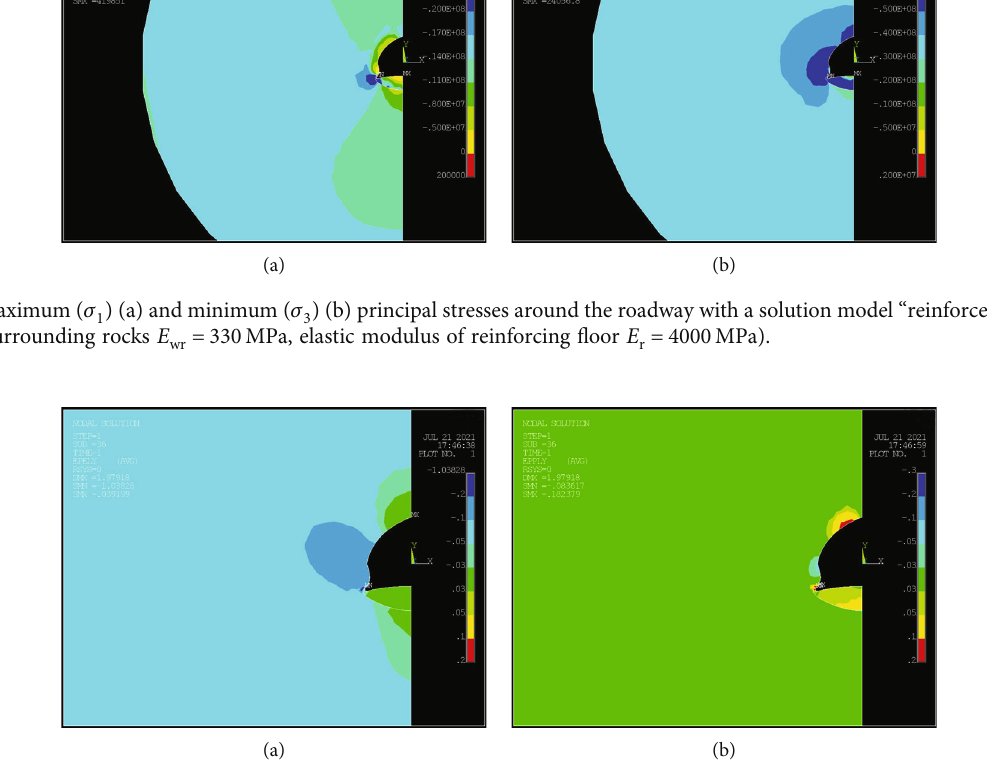
Figure 12: Vertical elastic (a) and plastic (b) strains around the roadway with a solution model “ reinforced fl oor ” (elastic modulus of surrounding rocks E wr = 330 MPa, elastic modulus of reinforcing fl oor E r = 4000